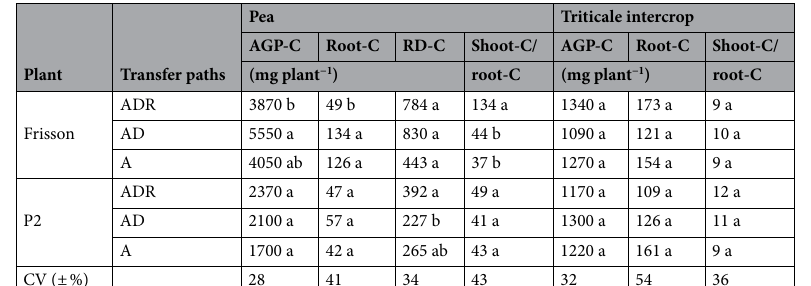
and transfer path treatments. Mean AGP-C of Frisson and P2 followed AGP-N, with C/N ratios of 13 and 20, respectively, as calculated from the data in Table 4. Mean root-C and RD-C of Frisson and P2 followed root-N and RD-N, with average C/N ratios of 17 and 24, respectively. Mean AGP-C and root-C of triticale followed AGP-N and root-N, resulting in C/N ratios of 9 and 22, respectively, without pea variety effects. Microbial biomass nitrogen (MBN) and microbial biomass carbon (MBC) varied around mean contents of 29.3 and 197 µg g −1 soil, respectively, leading to an average MB-C/N ratio of 6.7, without pea variety and transfer path treatment effects on these three microbial indices, according to a two-way analysis of variance (Table 5). MBN contained 1.2% and MBC 2.0% dfR, averaging all three Frisson treatments, but only 0.3% and 0.8% dfR, respectively, averaging the P2 treatments. In the triticale treatments AD and A, the respective average percentages were only 0.07% and 0.12%. Inorganic N and extractable C varied around mean contents of 44 and 100 µg g −1 soil. Inorganic N contained 0.04% and extractable C 2.2% dfR, averaging all three Frisson treatments, but only